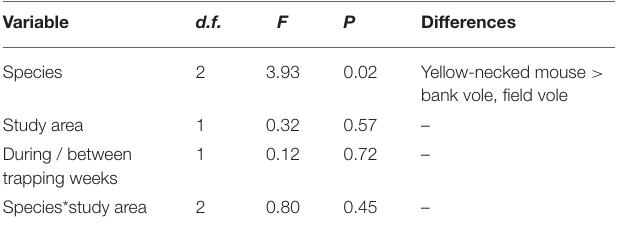
TABLE 4 | Relationship between dispersal distances of marked mice and voles, species, study areas and trapping sessions as determined by GLMM.